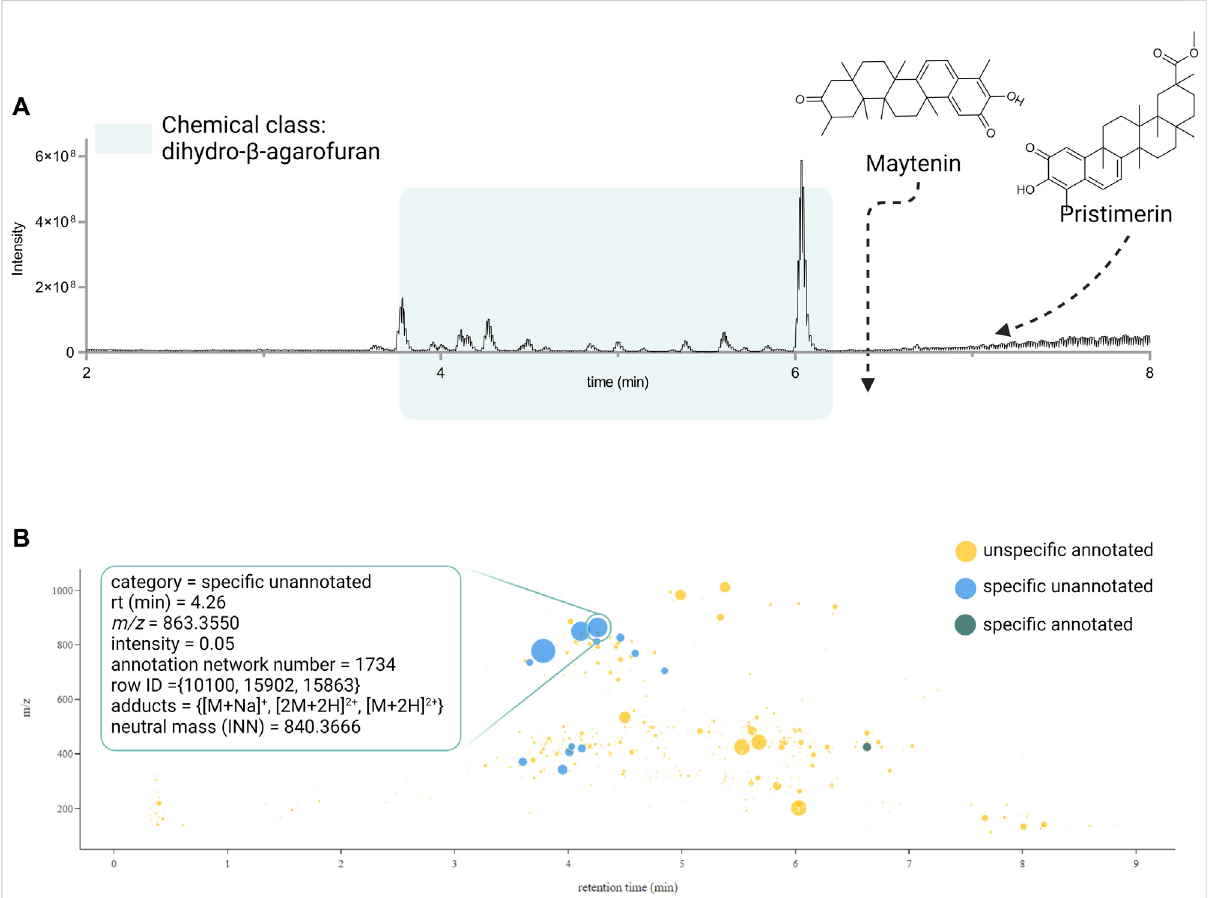
FIGURE 2 (A) UHPLC-HRMSchromatogram(BPIpositiveionmode)showingtheregionwherethedihydro- β -agarofuransesquiterpenoidsderivativesaresuspected anddisplayingtheonlytwocompoundsannotatedfor P.indica roots(plantwiththehighestPS). (B) Ionidentitynetworking-basedinteractiveionmapshowing thecombinedresultsoftheFCandCCfortheIIN.Insuchdisplayallfeaturesofasingleneutralmoleculearegroupedunderasinglespot.The IIN aredisplayed accordingtotheirstatus(speci fi cunannotated(blue),speci fi cannotated(green),andnon-speci fi cunannotated-notinteresting-(yellow)).Complementary information(adducts,rowid,chemicalclass, etc.)aredisplayedinteractivelyforeachIINifavailable,